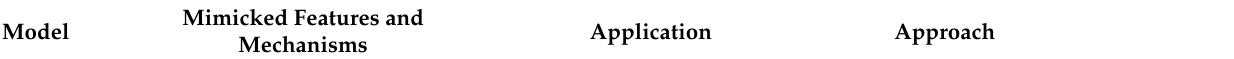
Table 1. Selected cases of biomimicry-based envelopes.